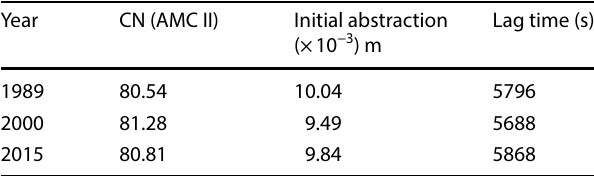
Table 8 The initial model parameters of Hayk Lake basin